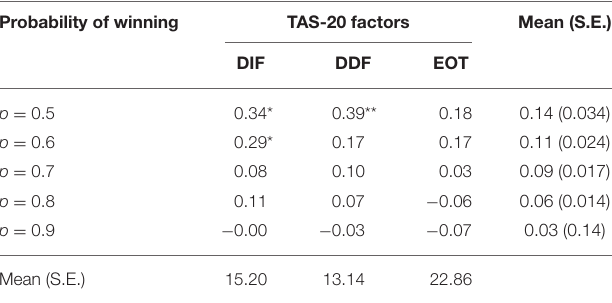
TABLE 8 | Correlations (means and standard errors) between the lost/won difference scores at each level of probability of winning and the three facets of